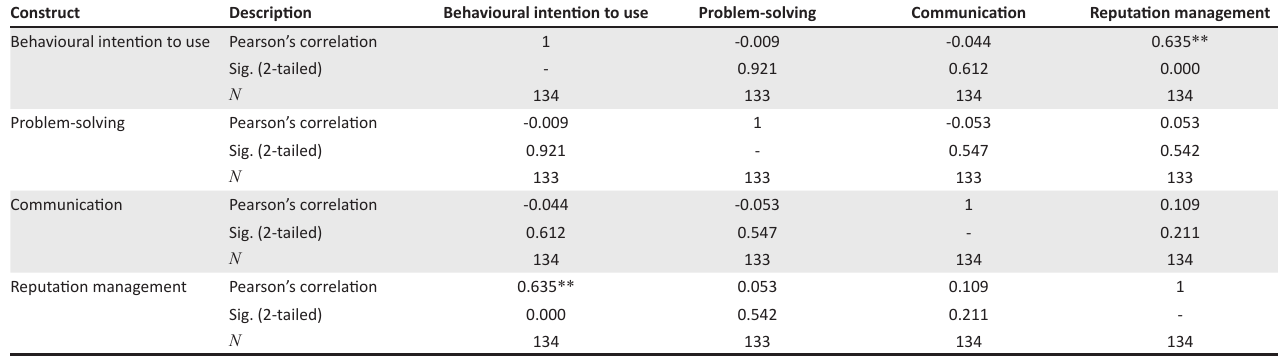
TABLE 5: Test of correlation between constructs. Construct